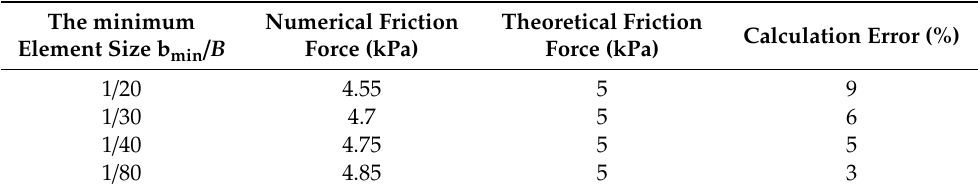
Figure 10. The test model. Table 2. Numerical cases and results.